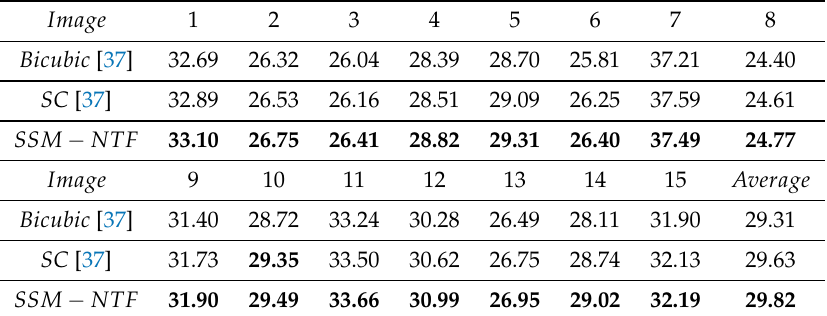
Figure 7. Visual quality comparison of SR results for Image 12 corresponding to Table 3. From left to right: Original image, result of bicubic interpolation ( PSNR = 30.28), [32] ( PSNR = 30.62) and our SSM-NTF method ( PSNR = 30.99), respectively. Table 3. PSNR (dB) for 3 × SR reconstructions